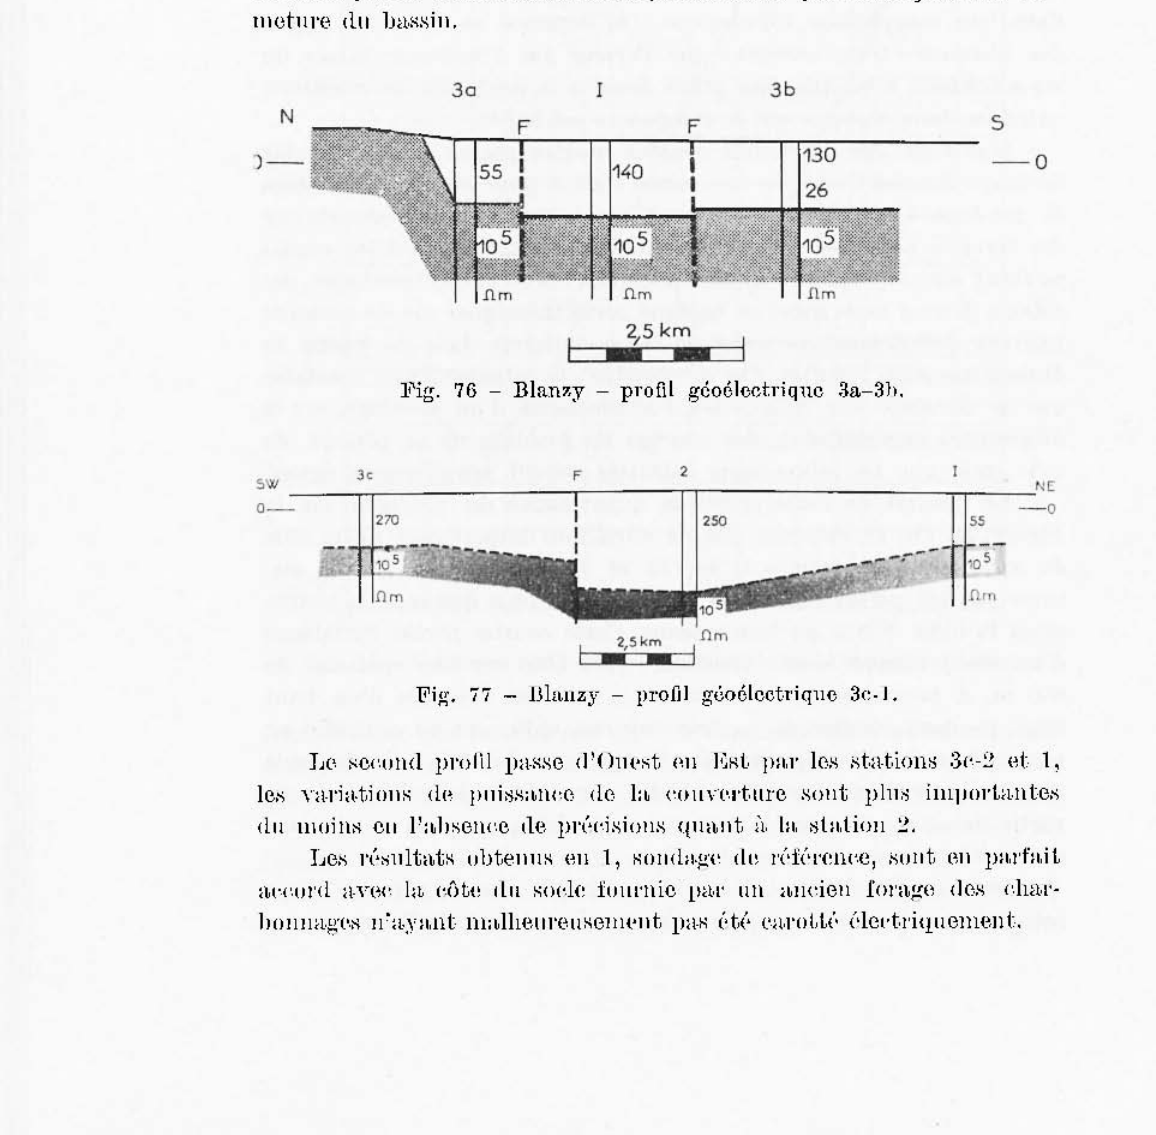
Fig. ii Blauzy - profil géoélcctl'iqllc 3e.